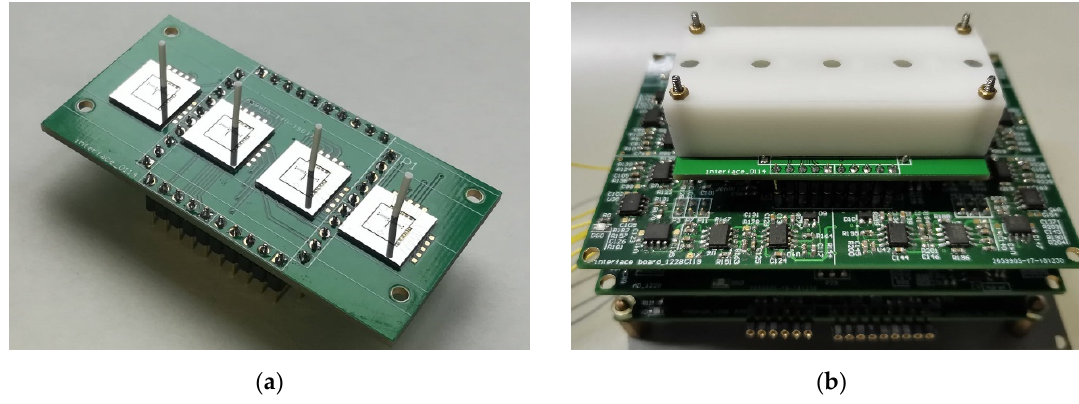
Figure 15. The artificial lateral line system. ( a ) Superficial flow velocity sensor; ( b ) Canal flow velocity sensor